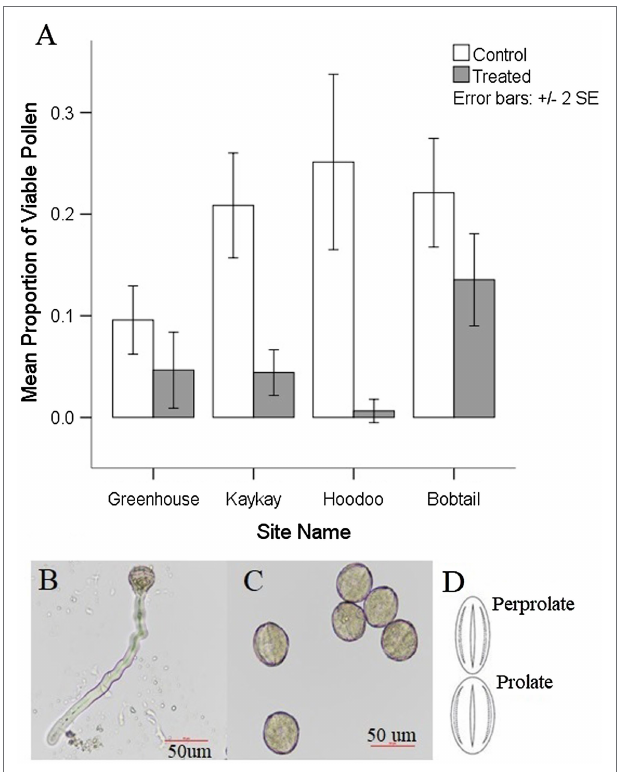
FIGURE 4 | (A) Average pollen viability present in R. acicularis flowers collected from operational forestry cutblocks treated with glyphosate-based herbicides and control areas sampled in northern BC, Canada, one-year post-glyphosate treatment, as well as the pollen viability from a controlled greenhouse experiment with roses treated at 0.45 kg a.i./ha. Standard error is represented. (B) Viable rose pollen from a control individual undergoing germination (formation of the pollen tube). (C) Nonviable pollen from a treated individual that did not produce pollen tubes after exposed to germination media. (D) Most common shapes for pollen grains found on R. acicularis in operational and experimental sampling in northern British Columbia, Canada (original figure in Wronska-Pilarek and Jagodzinski,